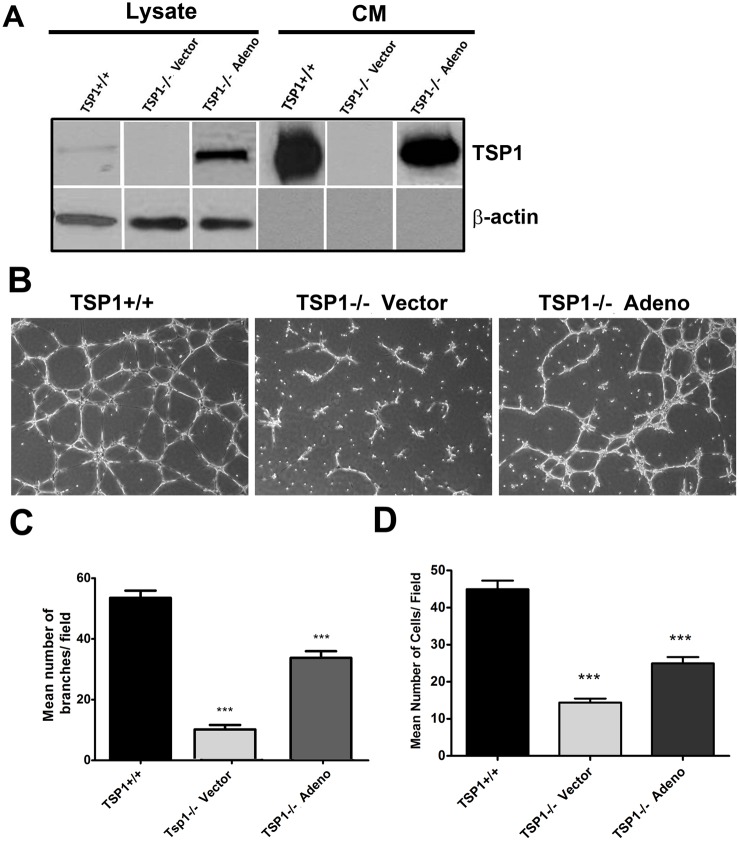
The re-expression of TSP1 in TSP1−/− ChEC.
A : TSP1−/− cells were infected with viruses encoding TSP1 as detailed in Methods. The expression of TSP1 was confirmed by Western blot analysis. B: The capillary morphogenesis of TSP1−/− ChEC expressing TSP1 in Matrigel. Please note the restored capillary morphogenesis of TSP1−/− ChEC after re-expression of TSP1. C: The quantitative assessment of capillary morphogenesis. Please note a significant increase in the capillary morphogenesis of TSP1−/−l ChEC expressing TSP1 (***P<0.001, n = 3). D: Restoration of migration in TSP1−/− ChEC cells expression TSP1, determined by transwell migration assay (***P<0.001, n = 3).